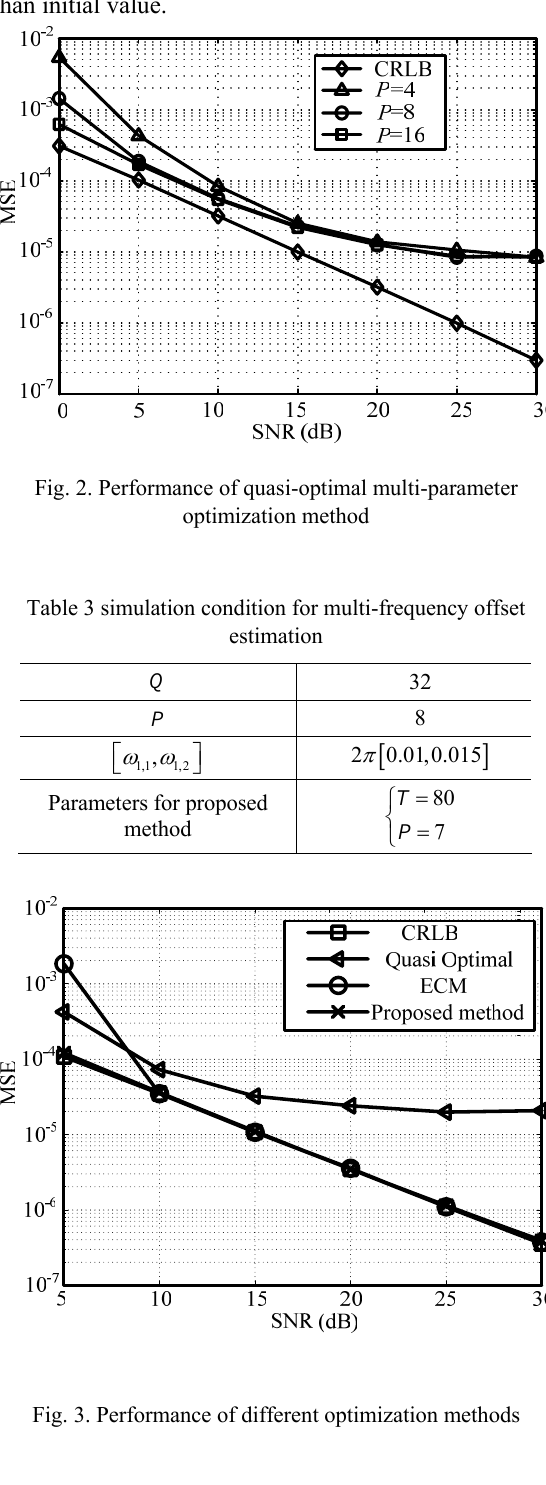
Table1. Summary of Estimation for the